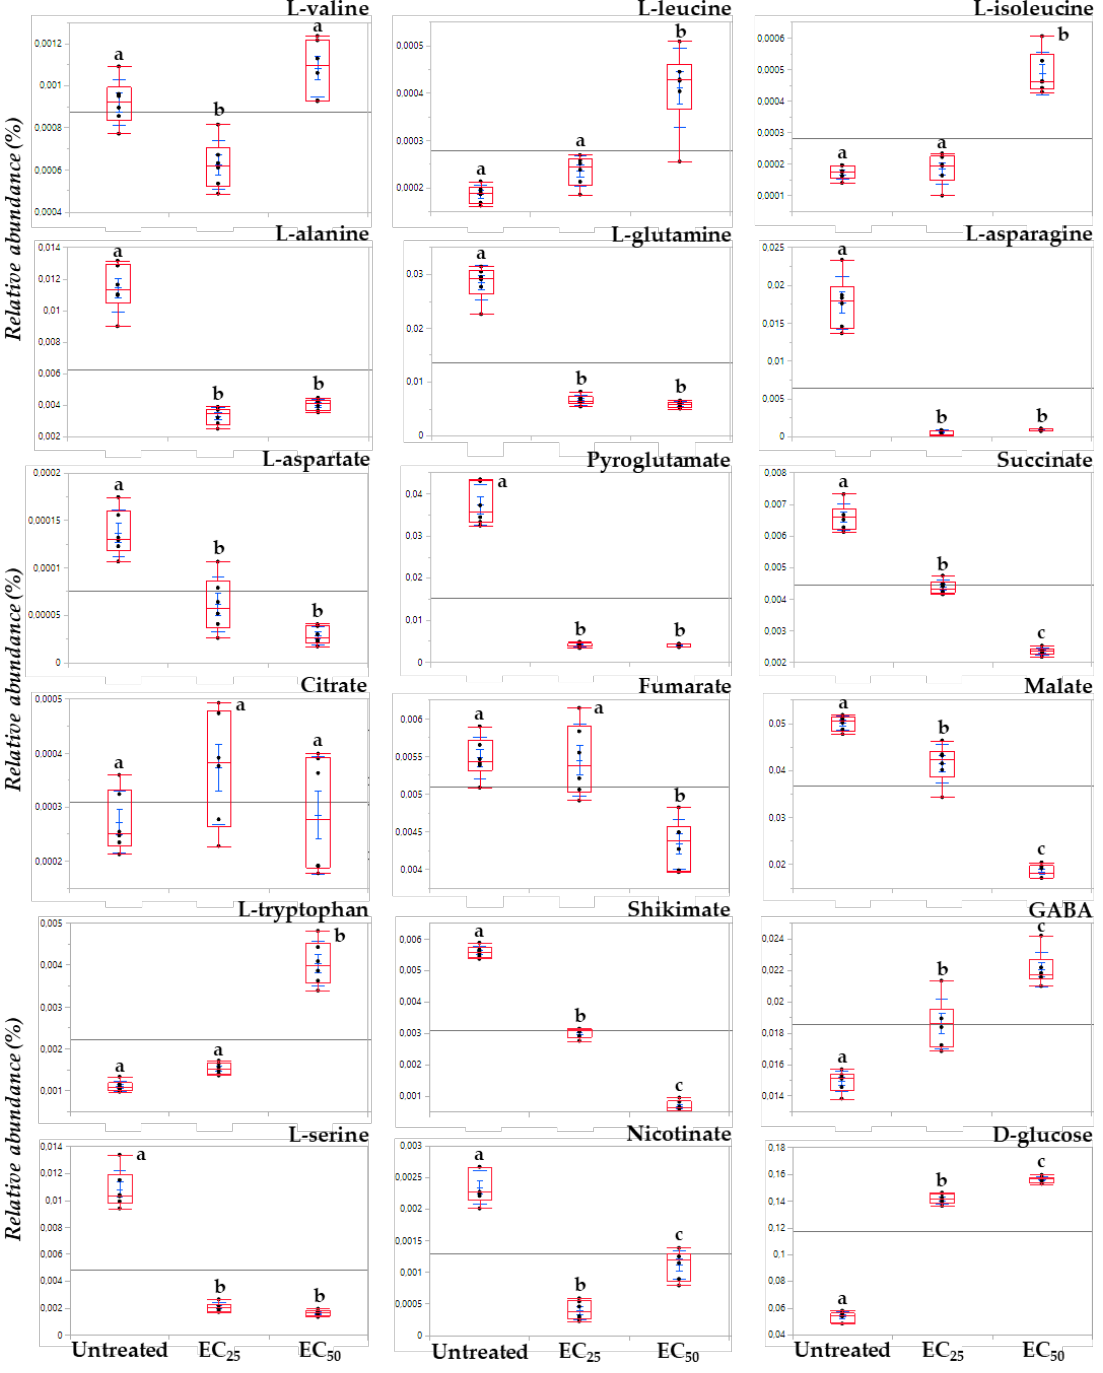
Figure 7. Box plots demonstrating the effect of the Bacillus sp. PTA13 lipopeptide extract on selected annotated Lemna minor L. metabolites 72 h following treatment with concentrations equal to the EC 25 (156 μg ‧ mL −1 ) and EC 50 (419 μg ‧ mL −1 ) values. In total, fifteen biological replications of two plants each were performed per treatment, every three of which were pooled to provide a pooled sample. Five pooled samples and one quality control sample were analyzed per treatment. The different letters above boxes indicate statical significance (Tukey HSD test, p > 95%).